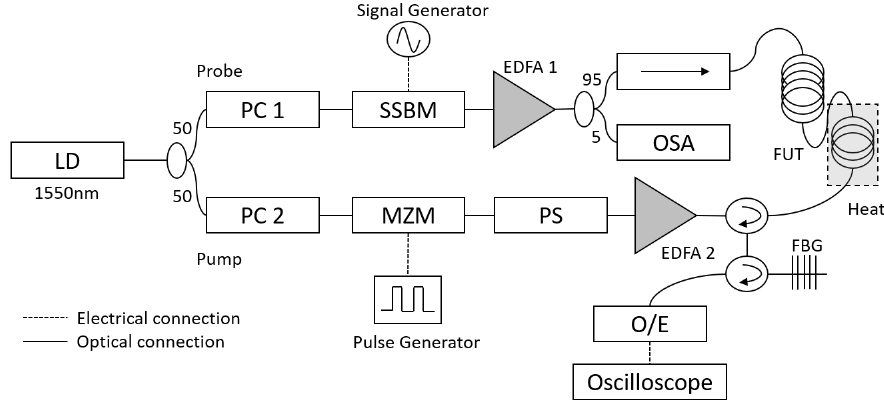
Figure 2. Experimental